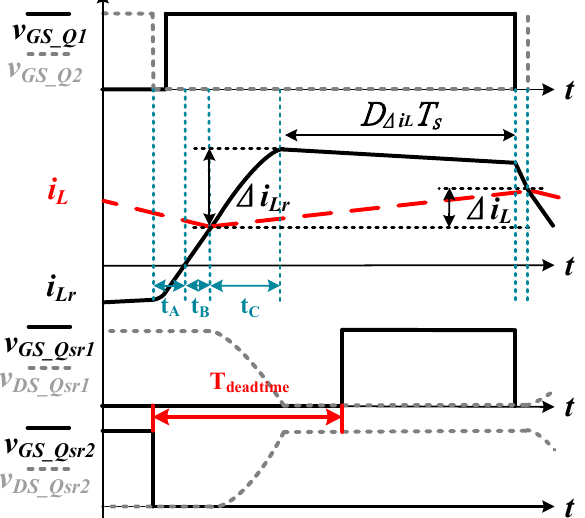
Figure 12. Detailed timing diagram of the switching operation.